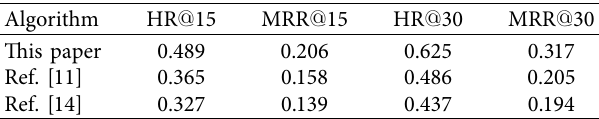
Table 2: Performance comparison of three algorithms on self-built data sets.